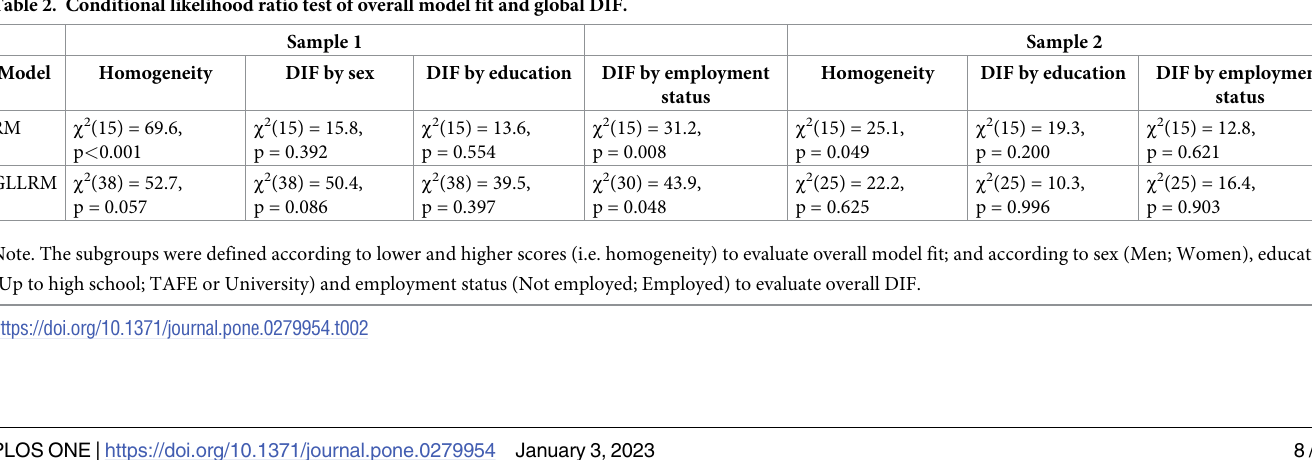
Note. Mean values, range, and standard deviations; numbers and percentages.